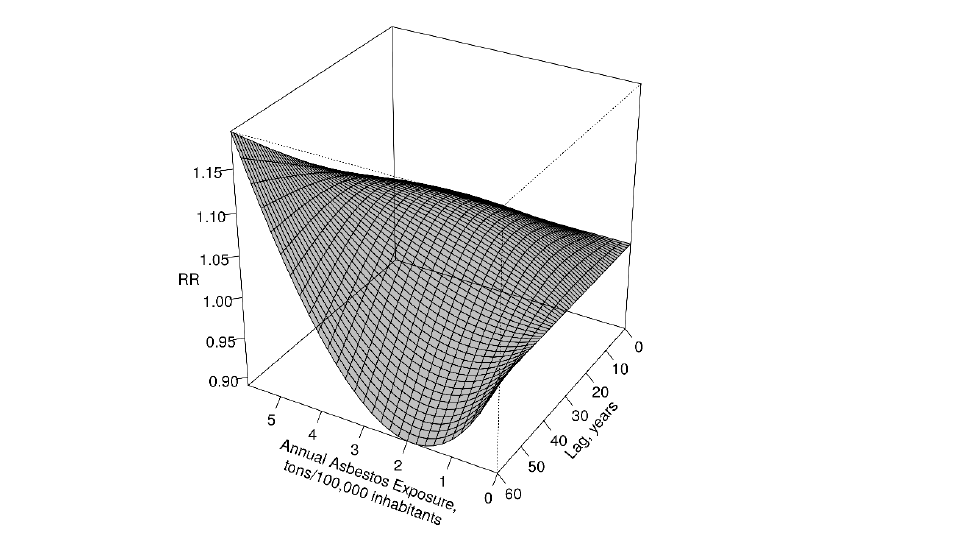
Figure 3. Exposure–lag–response association between the number of MPM deaths and the related past asbestos exposure (tons/100,000 inhabitants). Tridimensional exposure–lag surface.